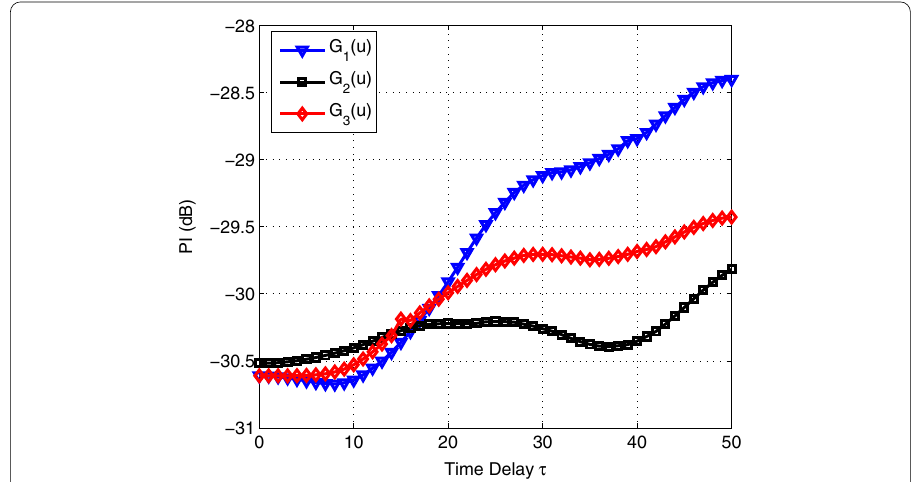
Fig. 2 Separation performance of the proposed algorithm at different time delay τ , sample length is 3000 and (cid:31) =